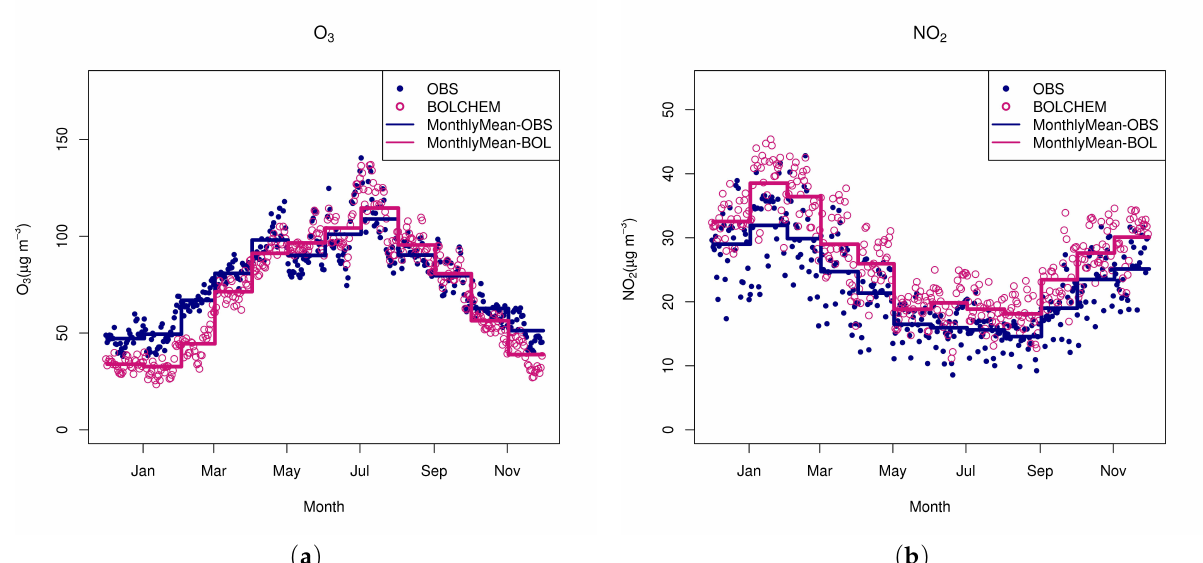
Figure 4. Average values calculated overall background stations for whole period of interest, from December 2009 to November 2010, for O 3 ( a ) and NO 2 ( b ). Maximum daily 1-h average concentration ( µ g m − 3 ) for O 3 and daily mean values concentration ( µ g m − 3 ) for NO 2 are plotted through blue filled circles (observations) and red empty circles (model). The monthly mean of the plotted concentration is represented with solid line (red line represents simulated value, while blue line represents measured